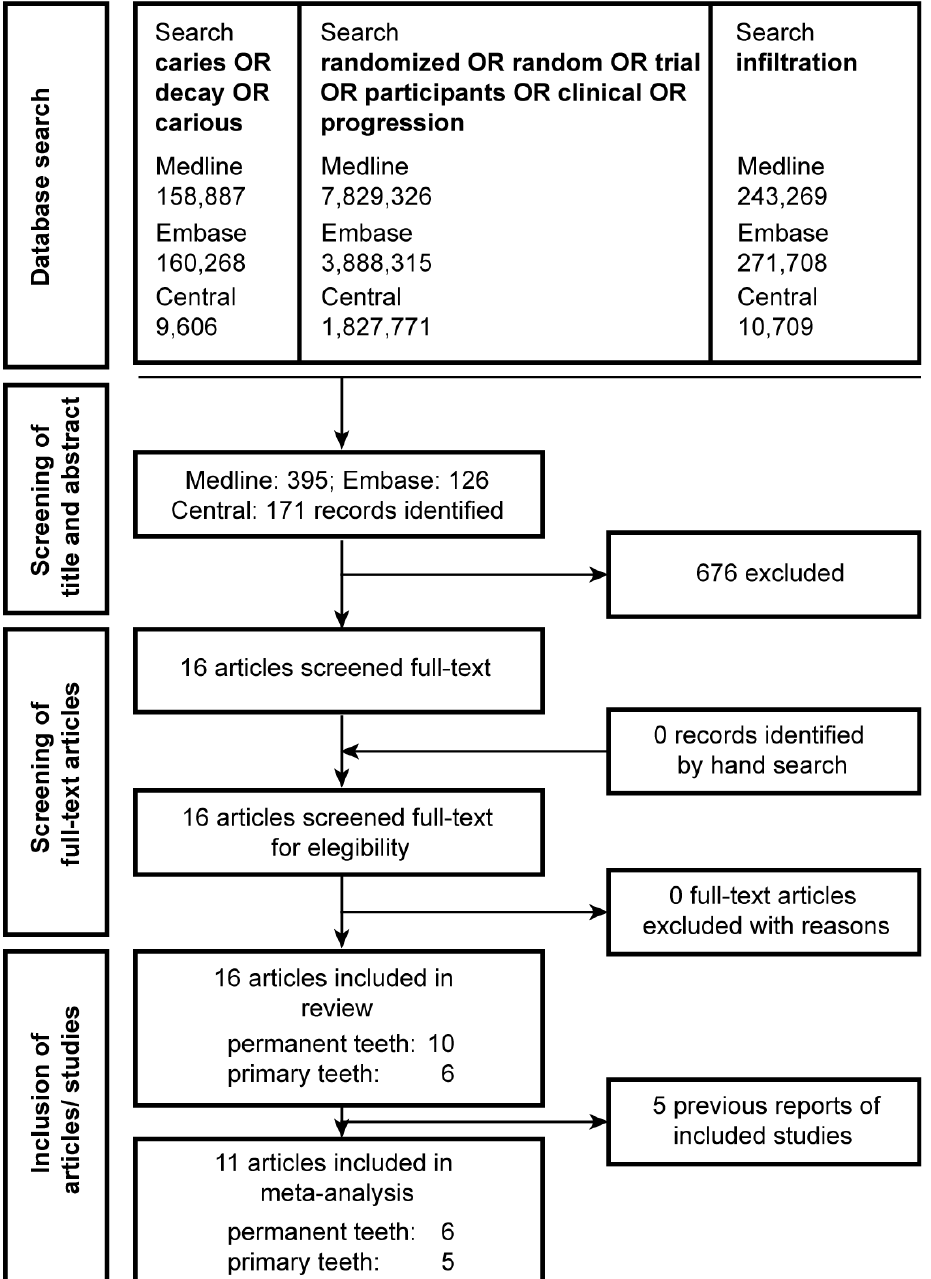
Figure 1. PRISMA flowchart of study selection. Search terms are indicated in the upper boxes, including the number of studies yielded for the three search groups. A combination of the three groups resulted in the number of records shown below the upper boxes. Five reports were excluded from the meta-analysis as they were earlier follow-ups of the included